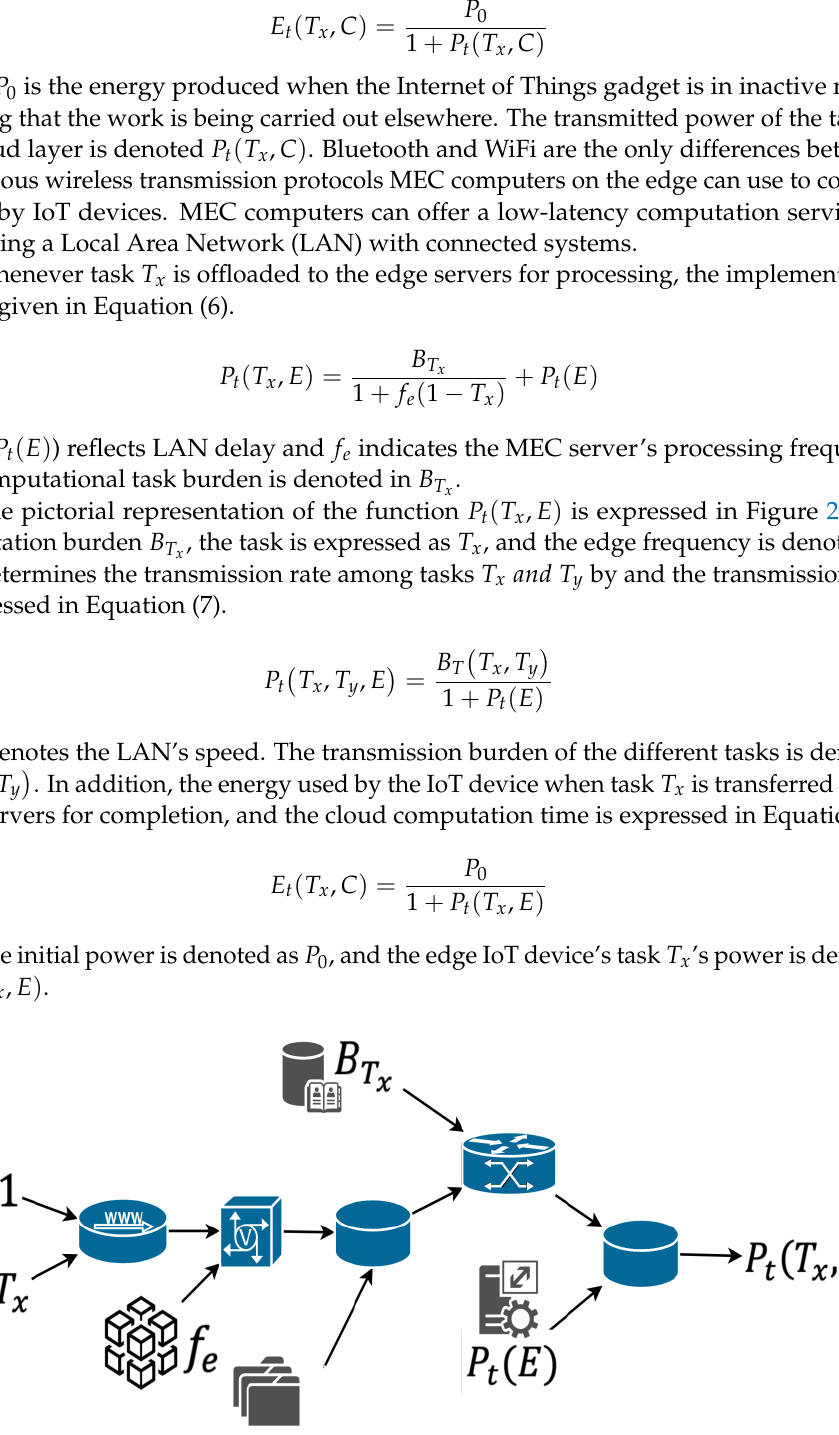
Figure 2. The pictorial representation of the function 𝑃 𝑡 (𝑇 𝑥 , 𝐸) .